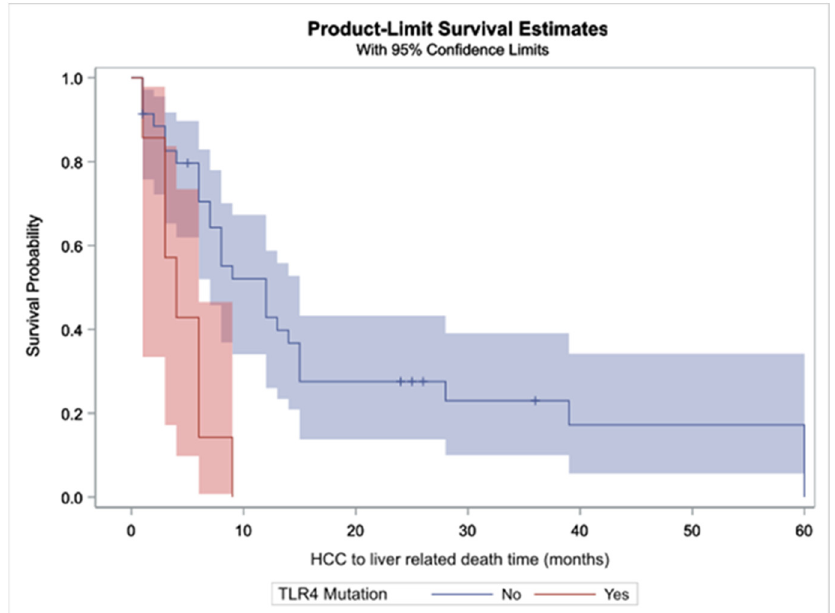
5 of 12 Figure 1. Survival curves for the patients with HCC in relation to TLR4 mutations. Shaded area indicates the 95% confidence interval. 2.4.3. Duration between HCC Diagnosis and Liver Related Death In relation to the survival of patients with HCC that died from liver-related causes, the median time between HCC diagnosis to liver-related death was 8 months (Q1–Q3: 6–13), for those with TLR4 mutations was 4 months (Q1–Q3: 1–6) and for those without, 12 months (Q1–Q3: 7–15). The relevant survival curves are depicted in Figure 2 showing